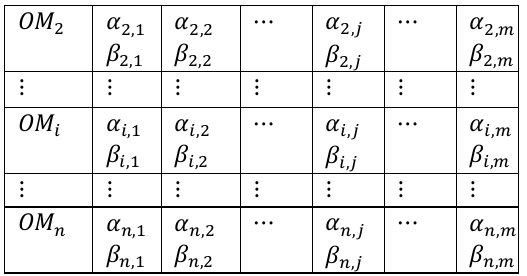
Table 2. The quantitative matrix, a corrected version of Peysson et al. (2008)